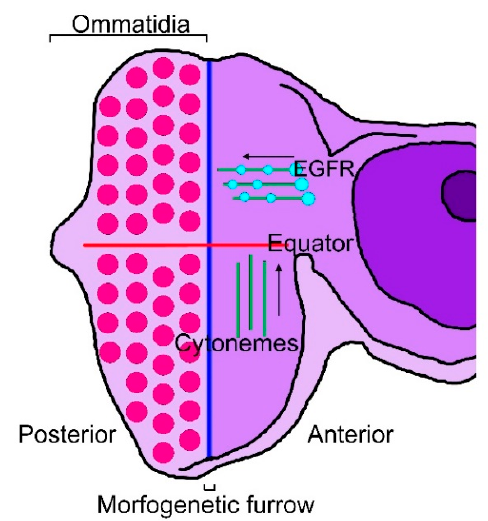
Figure 1. Cytonemes of the eye imaginal disc. Diagram of an eye disc in which the MF (blue line) has progressed from posterior to anterior, showing differentiated ommatidia in the posterior region of the eye disc (red dots). The equator is perpendicular to the MF (red line). There are two types of cytoneme (green lines) extending from cells anterior to the MF: (1) cytonemes oriented toward the equator and (2) cytonemes oriented toward the MF and populated with EGFR-containing puncta (light blue dots).